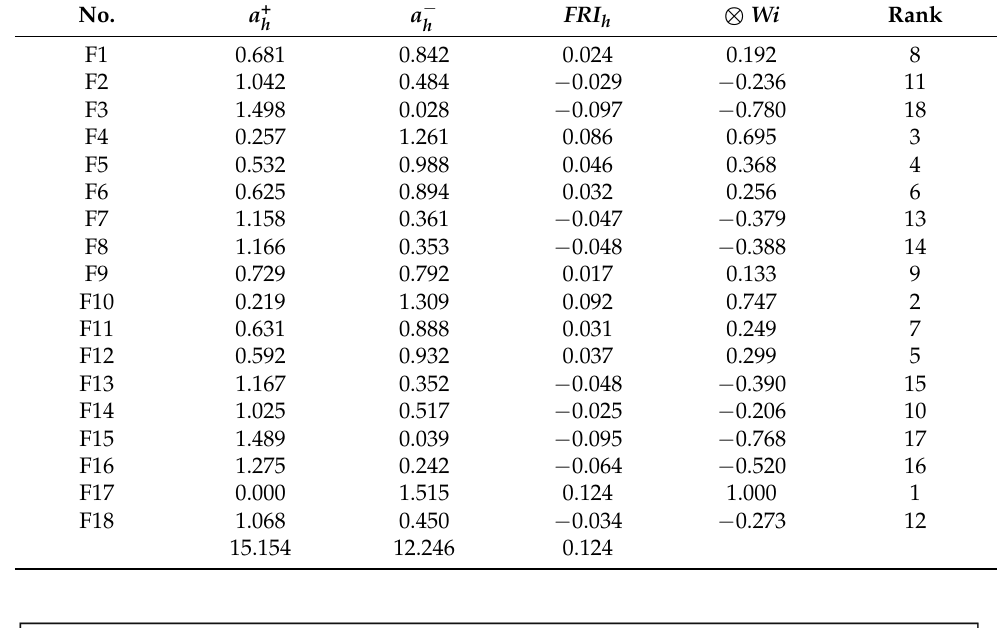
Table 11. Results of the PCIM − GRA method for ranking 18 failure modes.